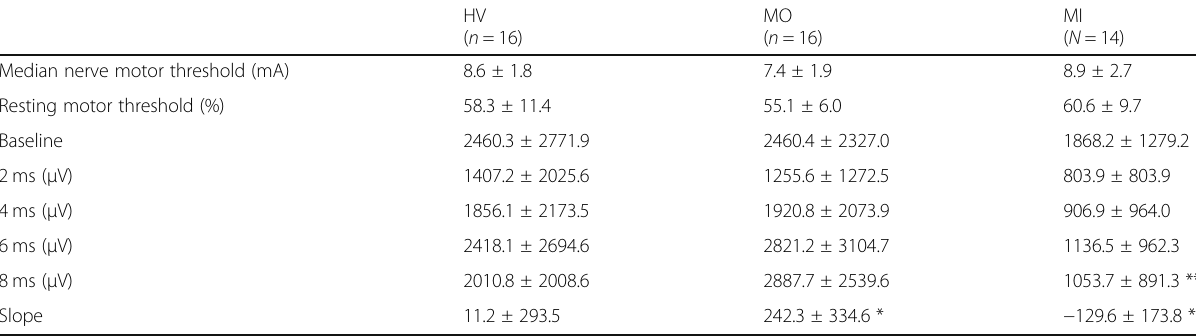
Table 3 Mean motor thresholds after median nerve and transcranial magnetic stimulation, baseline and conditioned amplitudes of motor evoked potentials (mean ± standard deviation) in healthy volunteers and migraine without aura patients between (MO) and during (MI) the attacks. ( p < 0.05 * MO vs. HV, ** MI vs. MO)